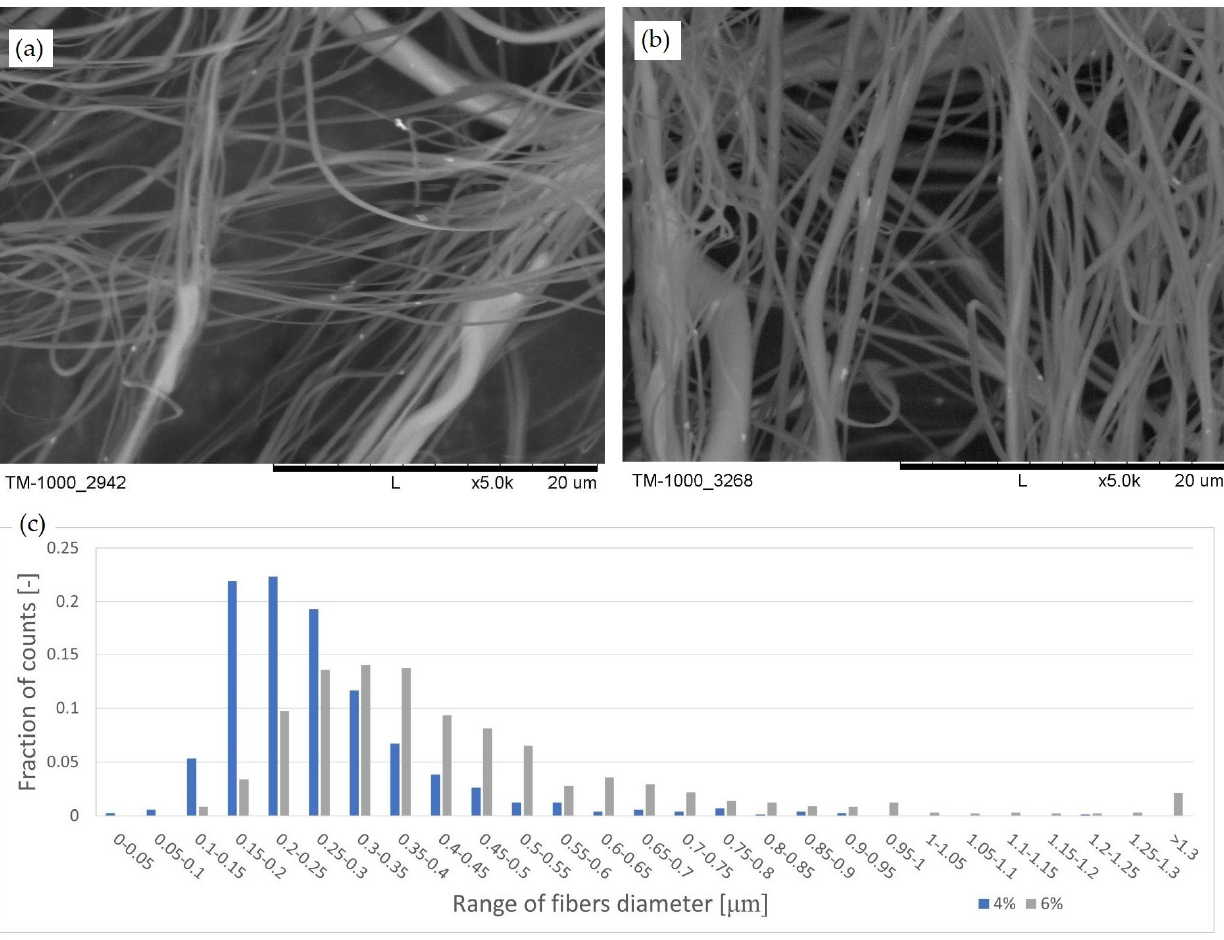
Table 2. Parameters of PLA